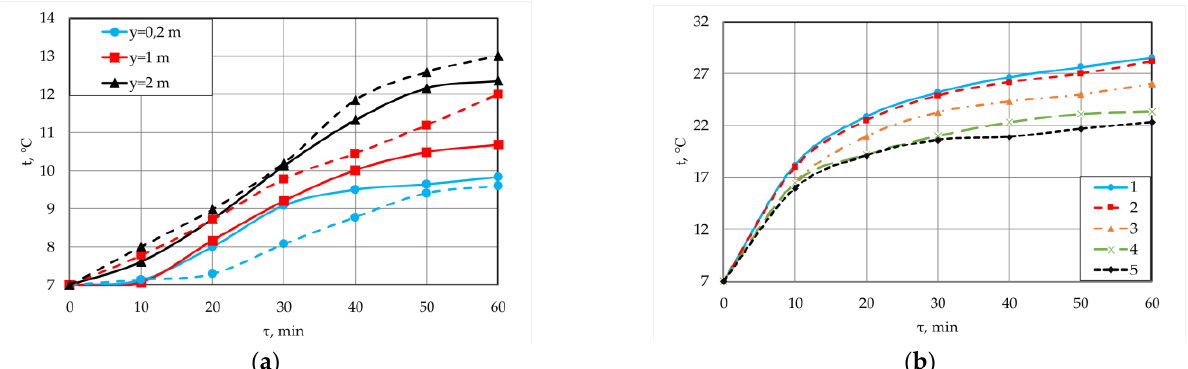
Figure 4. Floor surface temperatures change with increasing time at 0 ≤ X ≤ 1.0 m, Y = 0: ( a ) premises without equipment; ( b ) the panel is located at a height of 0.755 m from the floor.